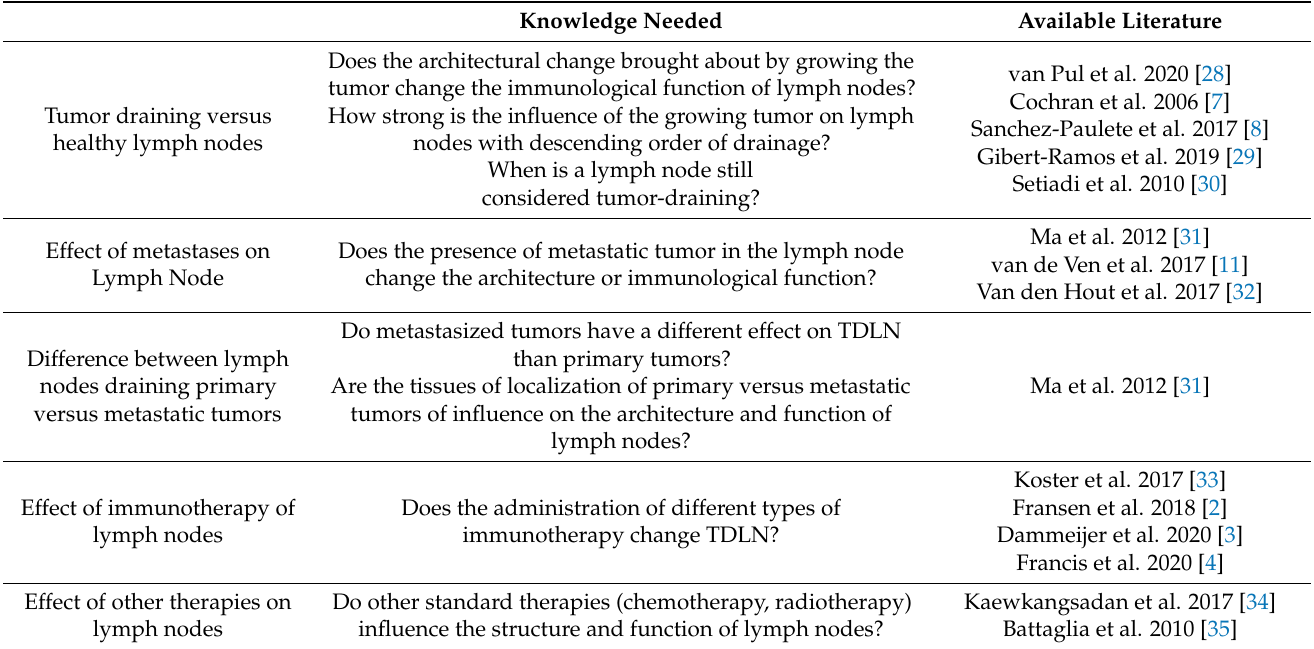
Table 1. Outstanding questions on the immunological function of